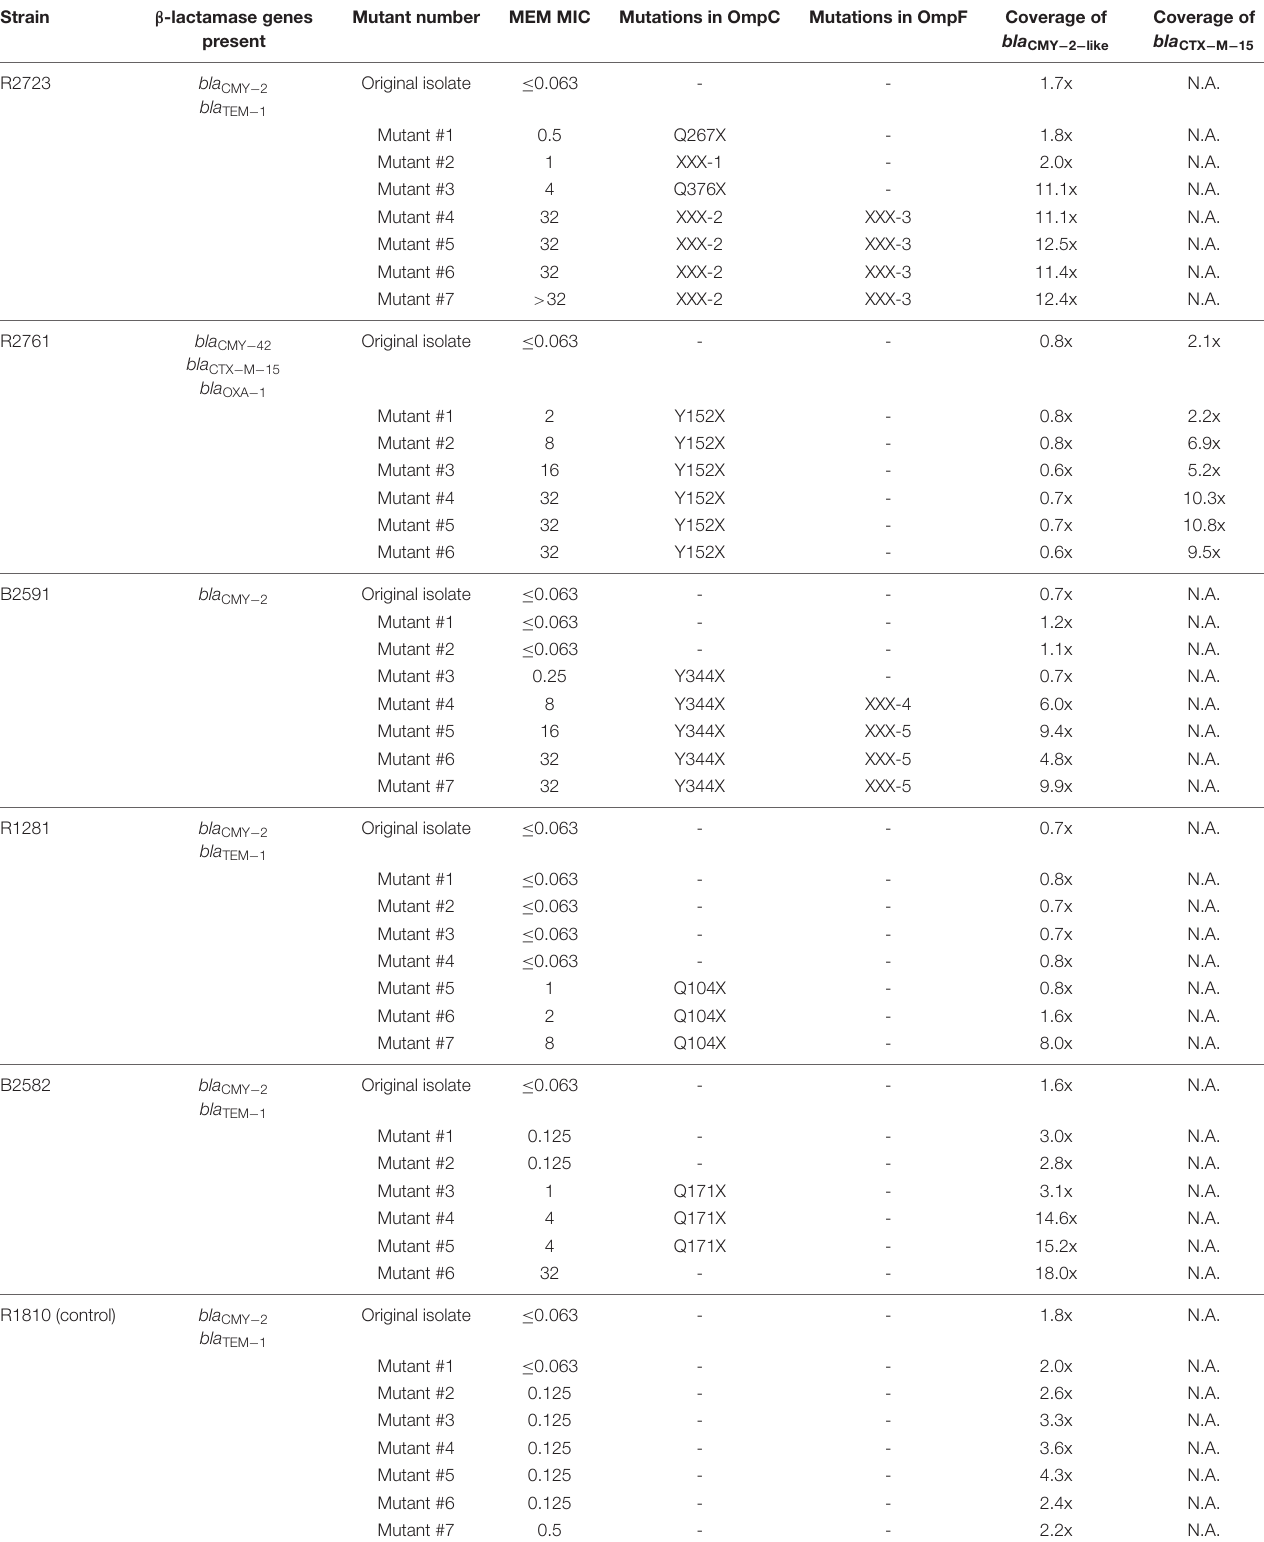
TABLE 2 | Characteristics of all mutants and identified causes for the loss of OmpC and/or OmpF, and the increase in CMY-2-like β -lactamases at the DNA level. Strain β -lactamase genes